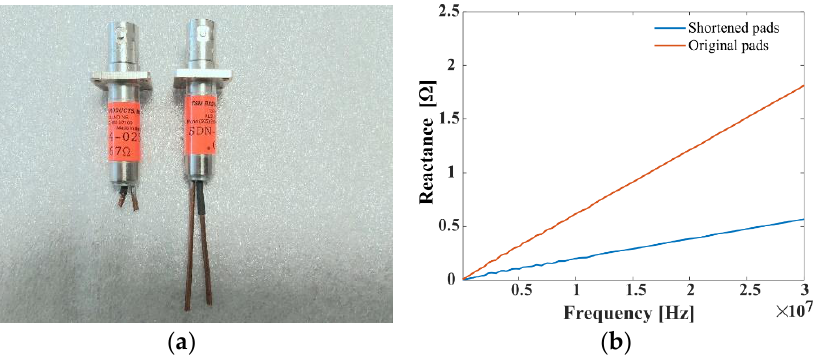
Figure 5. Detail of coaxial shunt: ( a ) with shortened pads (top) to reduce inductance, and original (bottom) with long 1” pads; ( b ) frequency response of reactance of current shunt resistor up to 30 MHz for original sensor (brown line) and shortened pads sensor (blue line).